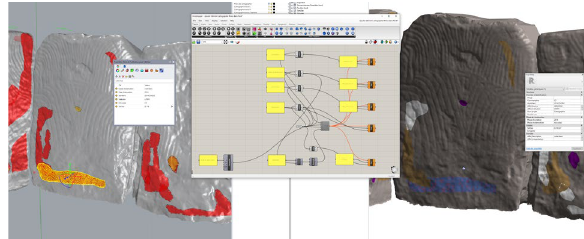
Figure 8. Element transfer from Rhino (left) to Revit (right) through Grasshopper